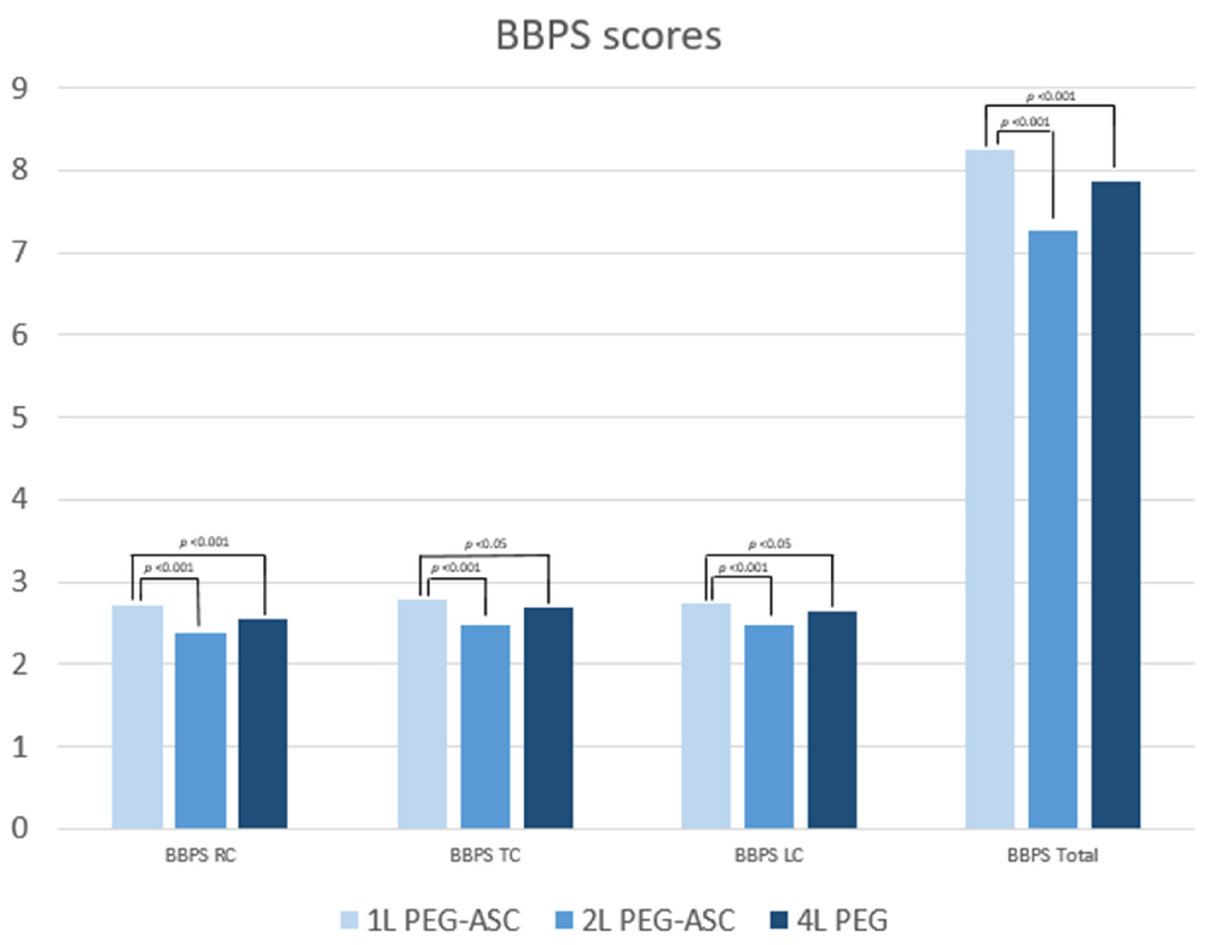
Figure 1. Boston Bowel Preparation Scores in the right colon (BBPS RC), the transverse colon (TC), and the left colon (LC), and BBPS total score (BBPS Total) for all study groups: 1L PEG ‐ ASC (light blue), 2L PEG ‐ ASC (blue), and 4L PEG (dark blue). PEG, polyethylene glycol; PEG ‐ ASC, polyeth ‐ ylene glycol + Ascorbate.